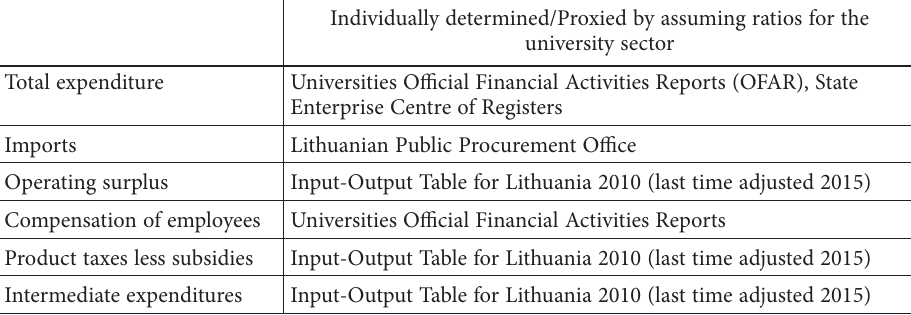
Table 4. Summary of HEI columns (source: compiled by authors) Individually determined/Proxied by assuming ratios for